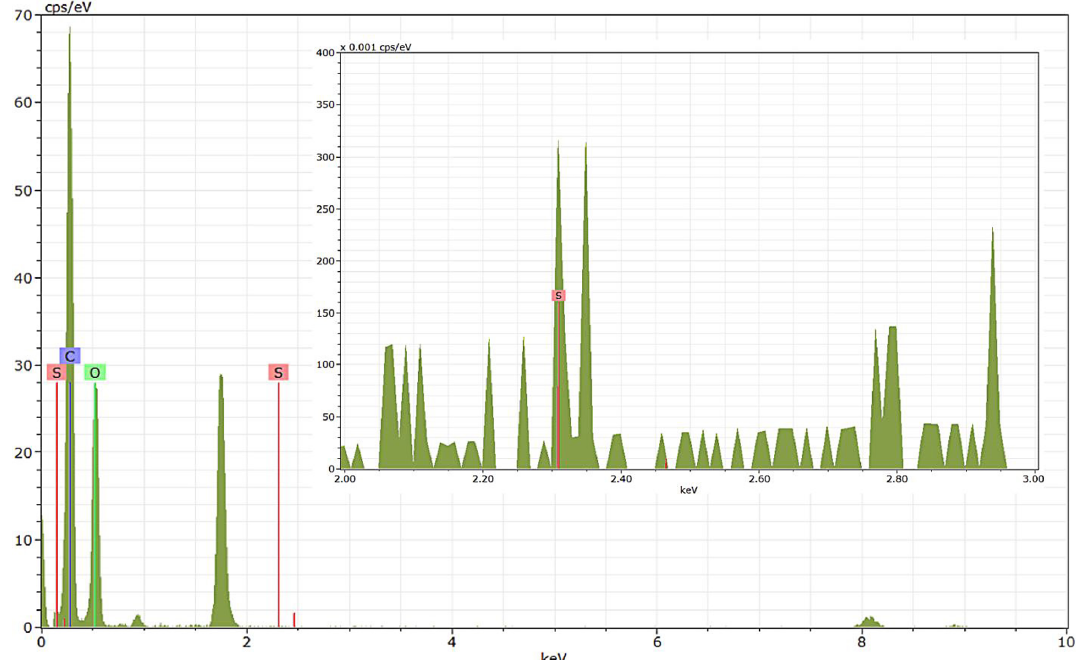
Figure C7. EDX spectra for AOI of thinly coated mCASTblack soot (H 2 SO 4 coating wt = 2.9%) presented in Fig. 10. The x axis stands for the electron energy (keV) and the y axis represents counts per second per eV (cpseV − 1 ). The position of carbon (C), oxygen (O) and sulfur (S) is indicated in the figure. The zoom-in patch shows the sulfur region of the spectra, which is not legible in the main